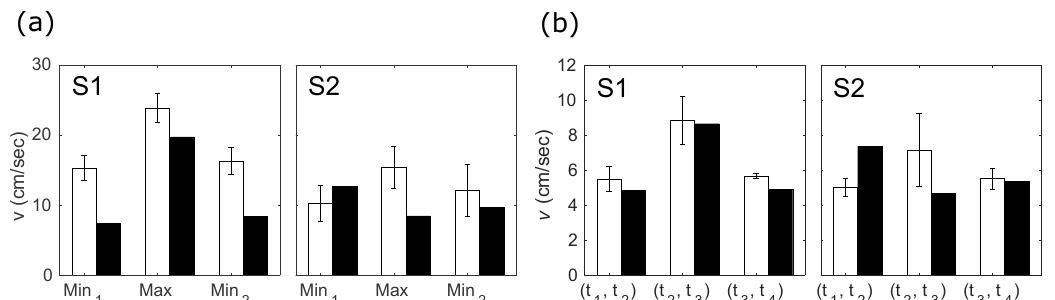
Figure 6. Velocity curves v (Time) and spectrograms s (Time, ν ) obtained from PC cine-MRI for subjects S1 and S2. Vertical dashed black lines on the velocity plots indicate time when velocity takes zero value, and denoted in correspondence with Figure 4. The filled zones indicate ( µ i − σ i , µ i + σ i ) for onset and offset of the both vowels, where µ is corresponding mean, σ is the corresponding standard deviation, and i is index of the zone. The spectrograms are obtained from the sound averaged on the 21 repetitions aligned with the MR images. The vertical solid lines denote averaged onsets and offsets for both vowels.